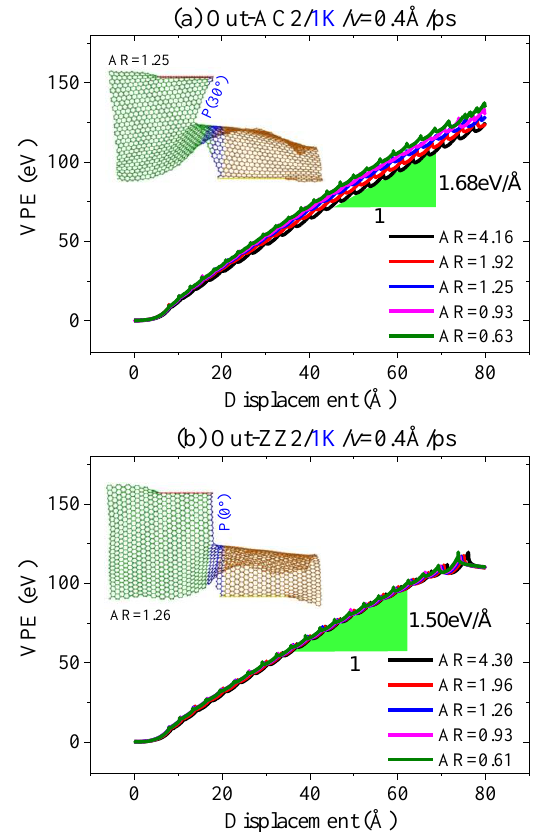
Figure 11. Curves of VPE out-of-plane tearing with the speed of v = 0.4 Å/ps at different aspect ratios and at 1 K: ( a ) armchair crack; ( b ) zigzag crack.